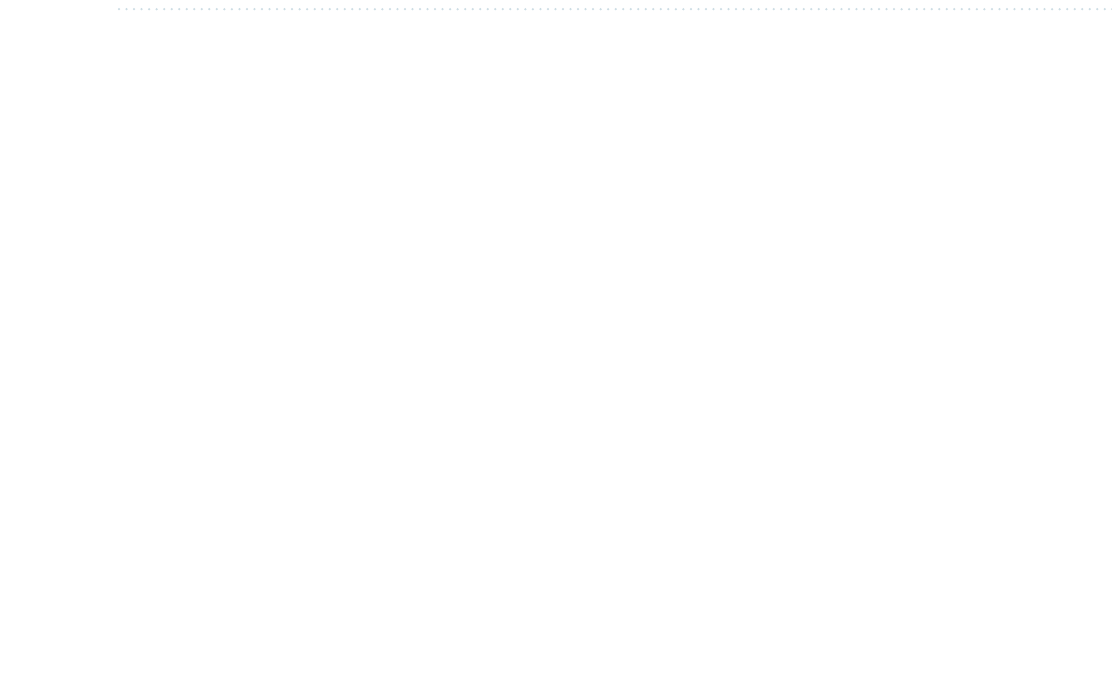
Figure 9. Prediction of 150 Telco type AS neighbor